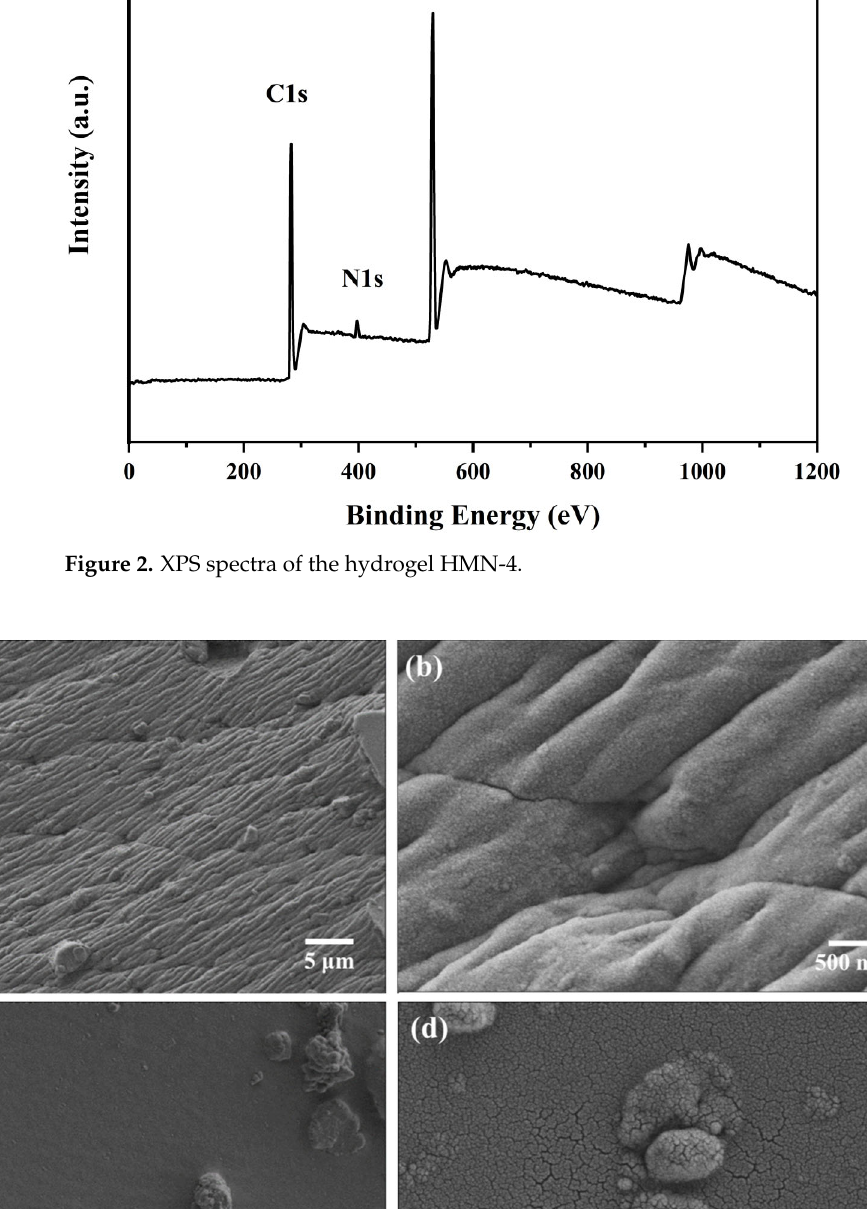
Figure 3. SEM images of ( a,b ) HMN ‐ 1 and ( c,d ) HMN ‐ 5.